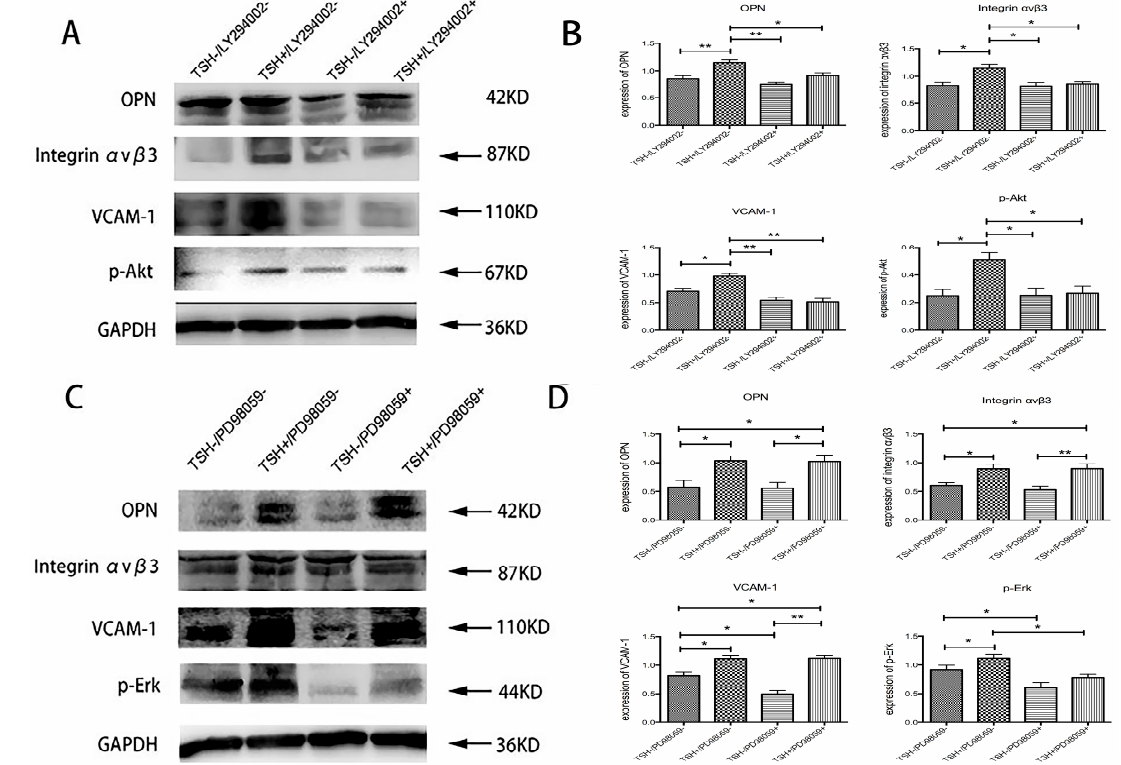
Figure 6. Effects of specific inhibitors on TSH-induced OPN, integrin α v β 3 , and VCAM-1 upregulation in HUVECs. HUVECs were pretreated with either 20 µmol/L LY294002 or 20 µmol/L PD98059 for 1h and then treated with 10 mIU/mL TSH for 24 h. ( A ) The bands depicted representative findings for the protein expression levels of p-Akt, OPN, integrin α v β 3 , and VCAM-1 in HUVECs as determined by Western blotting; ( B ) The bar graphs show the results of the semiquantitative measurements of of p-Akt, OPN, integrin α v β 3 , and VCAM-1; ( C ) The bands depicted representative findings for protein expression levels of p-Erk, OPN, integrin α v β 3 , and VCAM-1 in HUVECs, as determined by Western blotting; ( D ) The bar graphs showed the results of the semiquantitative measurements of p-Erk, OPN, integrin α v β 3 , and VCAM-1. The results are shown as the means ± SEM of three independent experiments. * p < 0.05 versus control; ** p < 0.01 versus control.